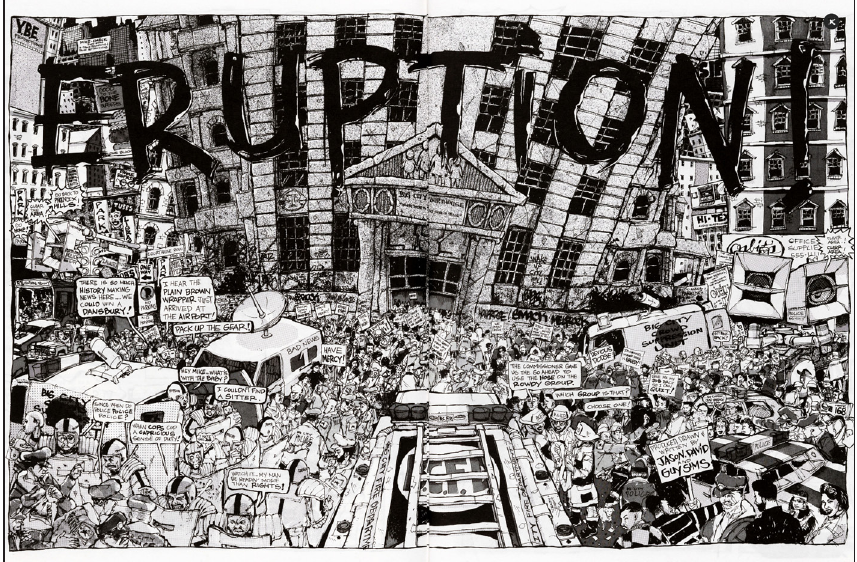
Figure 4: Excerpt from Sims J, Sims D, and Sims G (1992a) Brotherman: Dictator of Discipline #5 (East Orange, NJ) © Big City Entertainment,